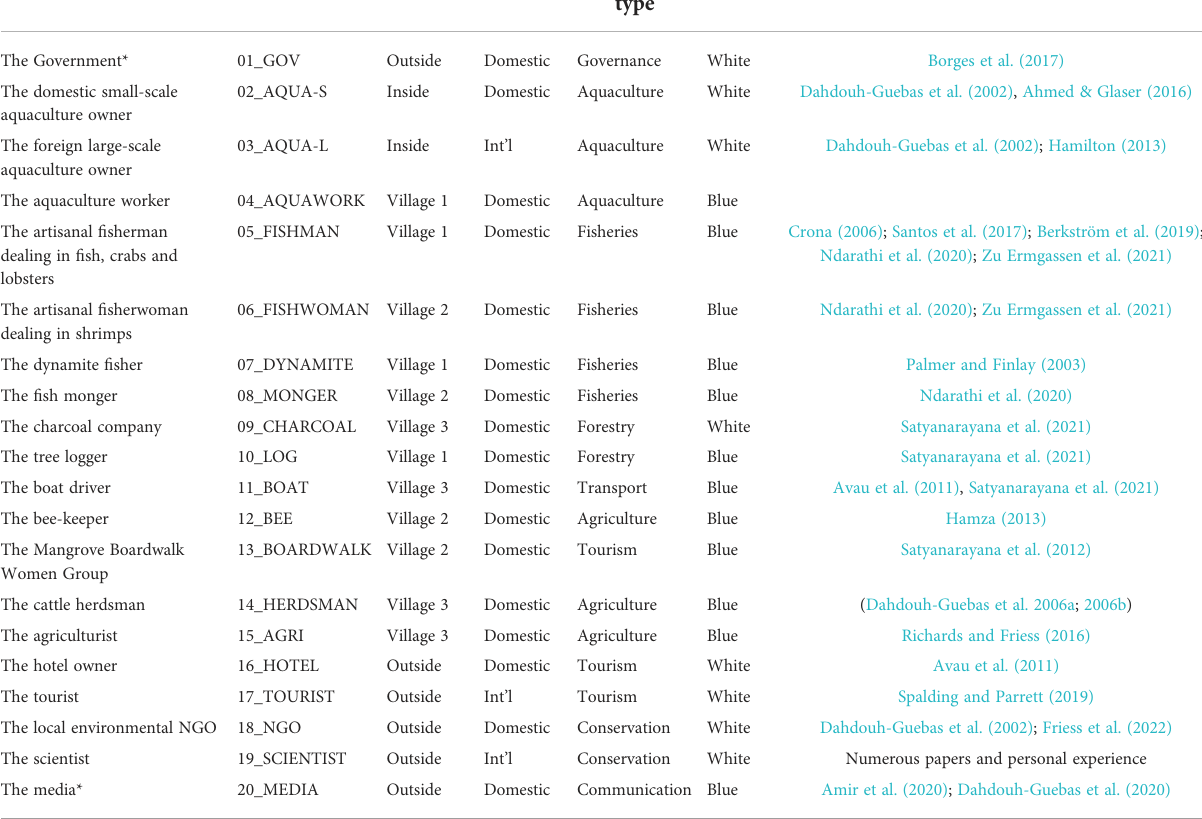
TABLE 2 Overview of the stakeholders involved in the Mangal Play ’ s SES.